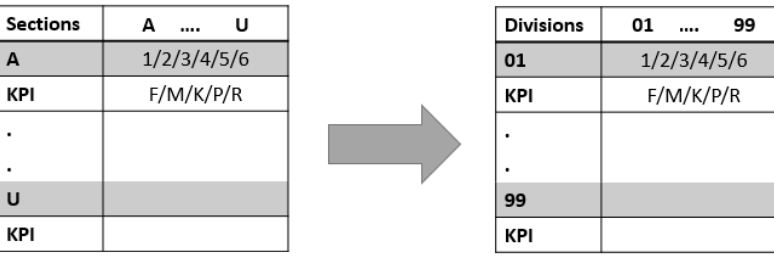
Table 2. The relation between industrial types and exchange